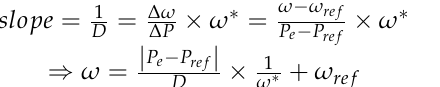
Table 1. No-Load Frequency of Different VSGs.